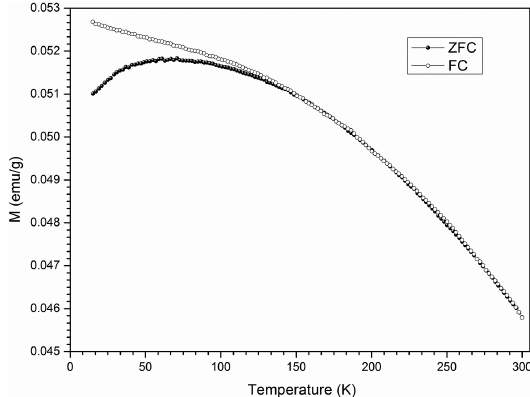
Figure 5. The magnetic property of the superparamagnetic PLGA-Mag nanospheres showing magnetization-applied magnetic field (M–H) magnetization curve.